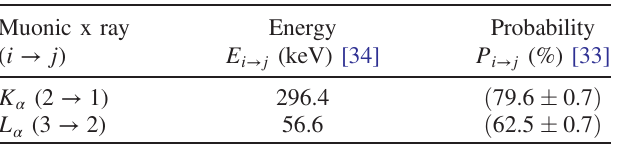
TABLE III. Energy and emission probability for different muonic x rays on